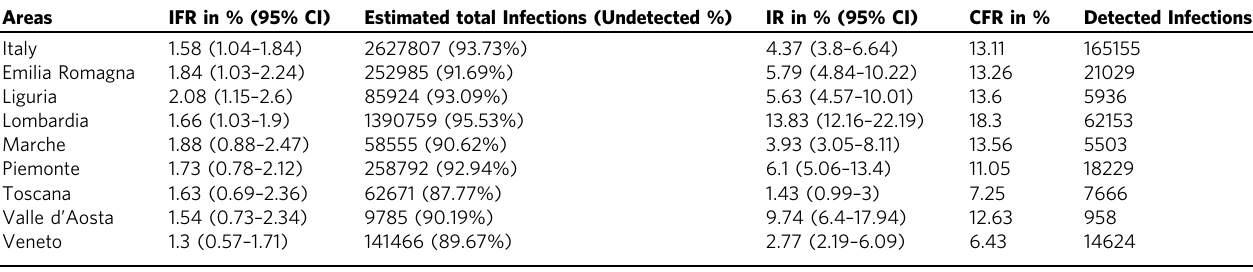
Table 2 Estimation of the total number of infections, the Infection Rate (IR), the Infection fatality rate (IFR) 1 .